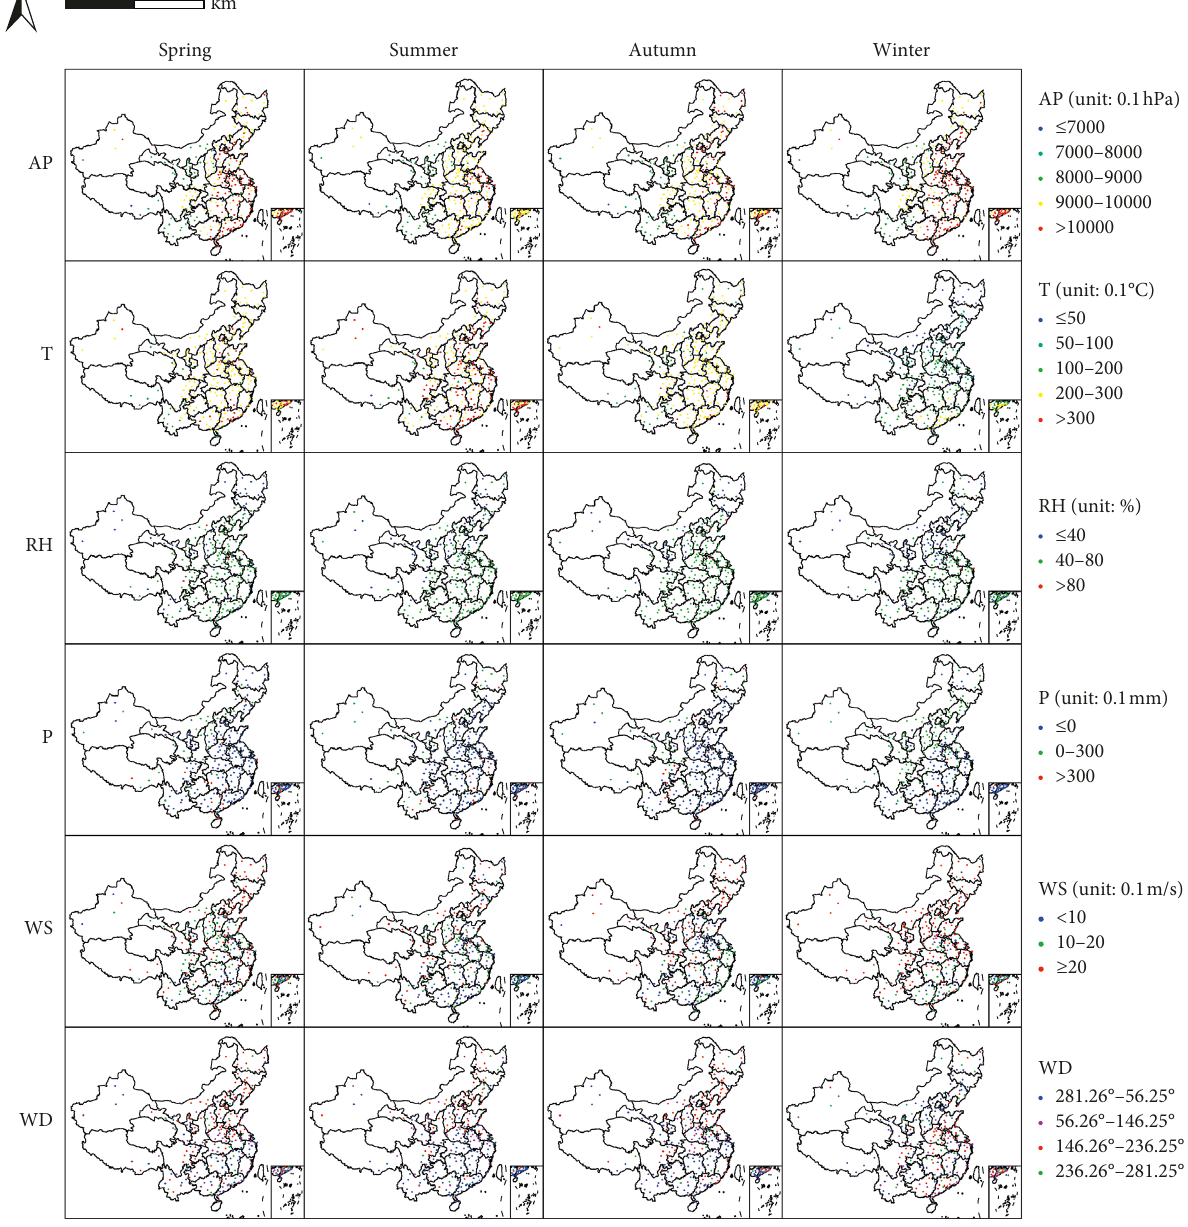
Figure 21: Spatial pattern of the impact of meteorological factors on O